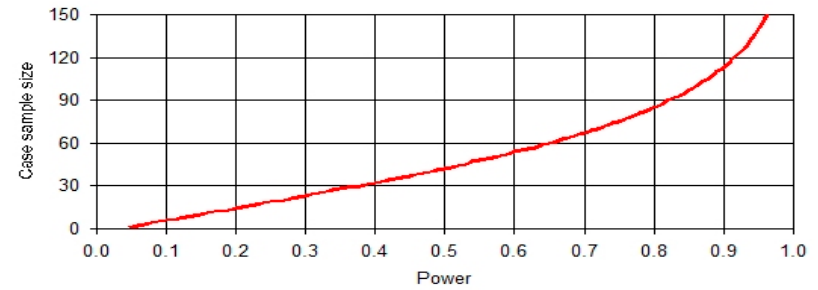
Figure 1. Graph of sample size against power